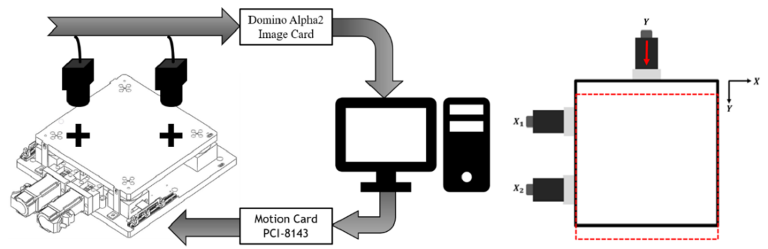
Figure 2. Configuration of the XXY stage system and illustration for the Y ‐ axis motion in the exper ‐ iment